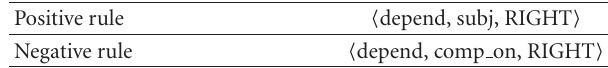
Table 1: Positive and negative rule sets for the sentence in Figure 1. Positive